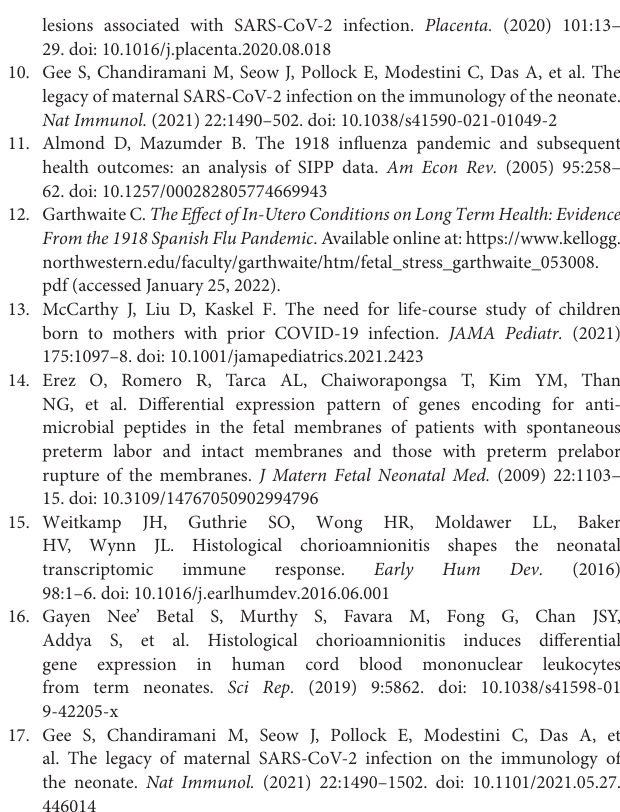
Supplementary Figure 1 | Sirtuin signaling pathway presented in this figure is the top-most canonical pathway picked up by Ingenuity Pathway Analysis (IPA) software (QIAGEN Inc., https://digitalinsights.qiagen.com/IPA) by loading the 510 probe sets that were differentially expressed with exposure to COVID-19. In mammals there are 7 sirtuin members (SIRT1-7) that are shown in this pathway. 18 genes involved in sirtuin signaling pathways were modified with exposure to COVID-19, red filled path designer shapes are upregulated genes and green filled path designer shapes are downregulated genes. Supplementary Table 1 | Differentially Upregulated ProbeID or Genes in COVID Group. Supplementary Table 2 | Differentially Downregulated ProbeID or Genes in COVID